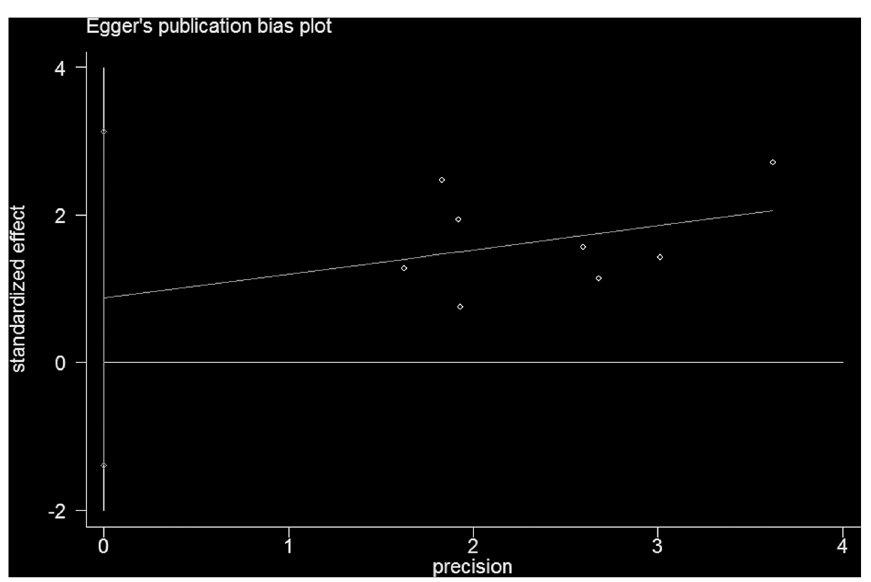
Fig 5. Egger ’ s test results for publication bias about dichotomous outcomes of 25(OH)D levels in CD.